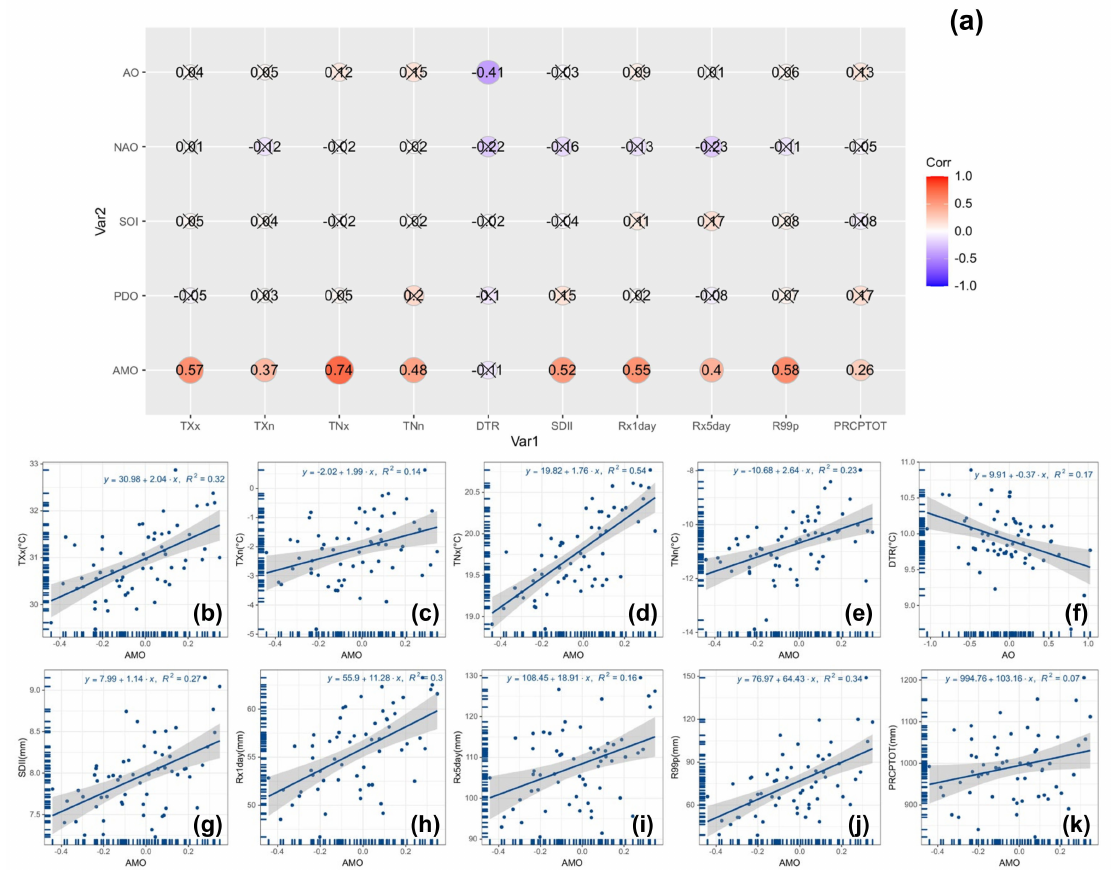
Figure 6. Correlation between extreme indices and climate indices in the YRB during 1961 to 2020. ( a ) The value of Pearson correlation coefficients and the “ × ” means that the correlation is not significant; ( b – k ) Scatter diagrams for significant correlation between extreme indices and climate